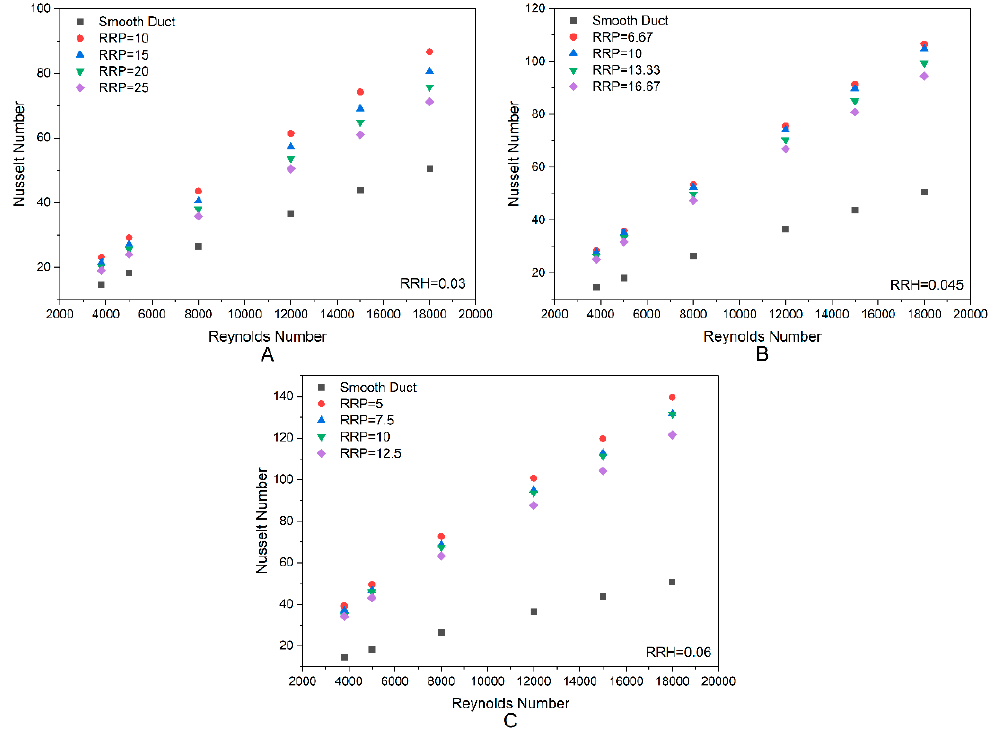
Figure 10. Nu r versus Re for ( A ) RRH = 0.03, ( B ) RRH = 0.045, and ( C ) RRH = 0.06.